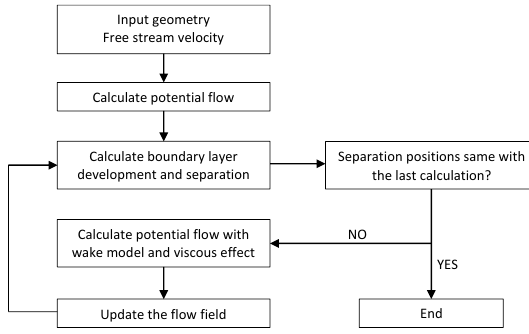
Figure 1. Flow diagram of the calculation procedure.